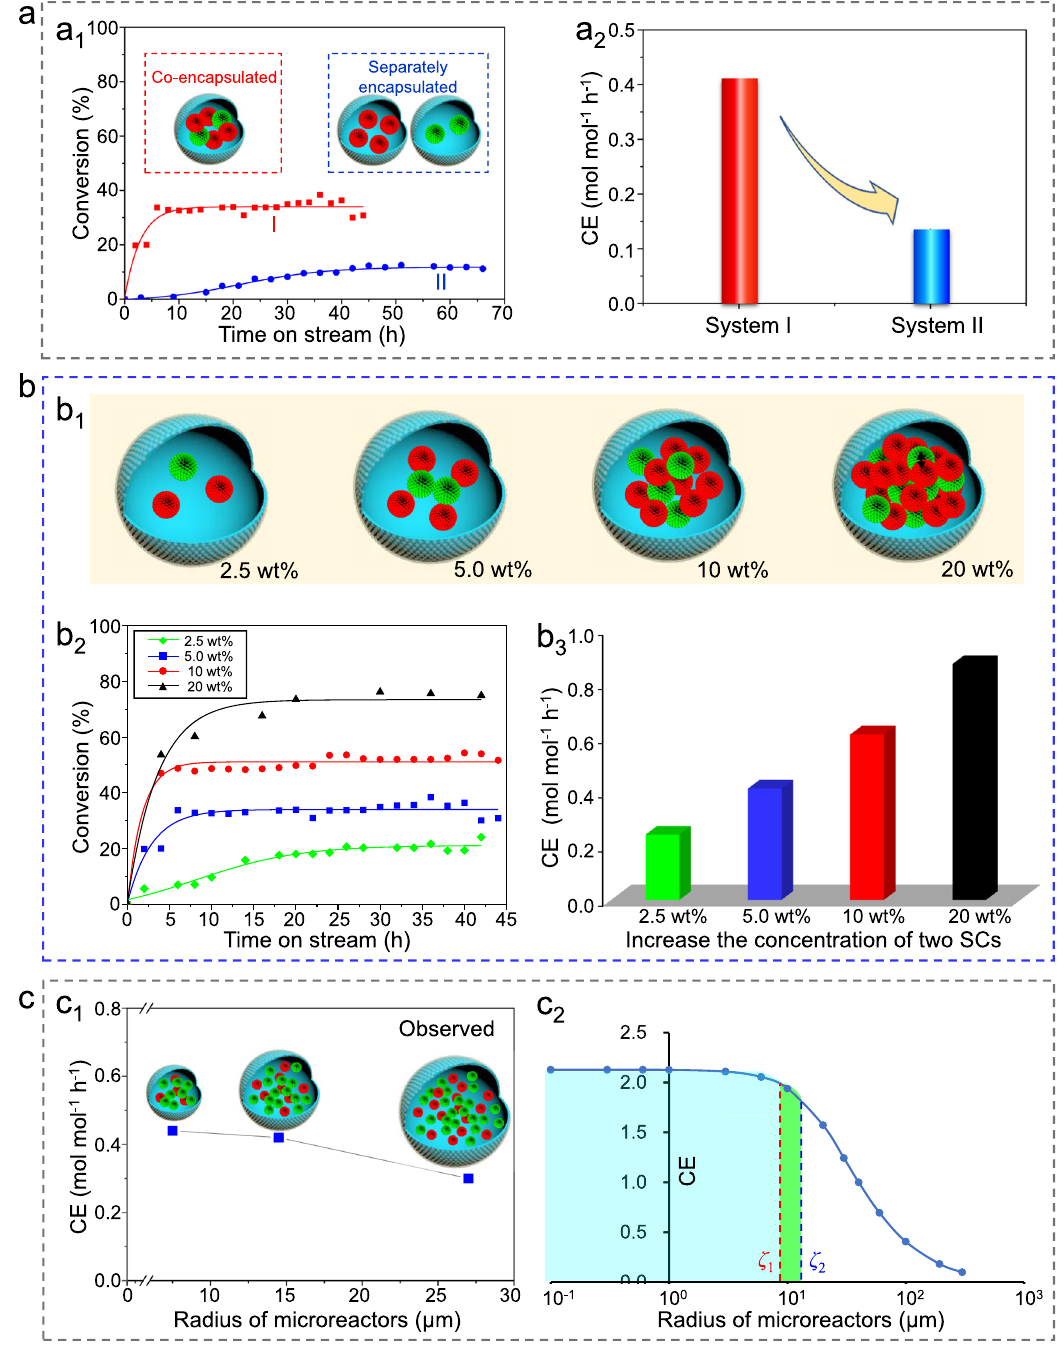
Fig. 4 Compartmentalization effects. a Impact of compartmental manner. a 1 Conversion with time for the chemo-enzymatic cascade fl ow reactions. The system I: two SCs co-localized within the same microreactor; system II: two SCs separately localized in different microreactors. a 2 CE of the system I and system II. b Impact of SCs concentrations within microreactor. b 1 Schematic illustration of the microreactor with varied local SCs concentrations but with fi xed total catalyst amount and catalyst ratio (Ti/SCs:CALB/SCs is 2:1). b 2 Conversion with time for the microreactors with different local SCs concentrations. b 3 CE as a function of SCs concentration. c Impact of microreactor size. c 1 CE vs. microreactor radius. c 2 Theoretically predicted CE for microreactor with different radii. ζ is the distance away from the microreactor surface. All of the reaction conditions are the same as those in Fig. 3c except for the fl ow rate (2 mL h − 1